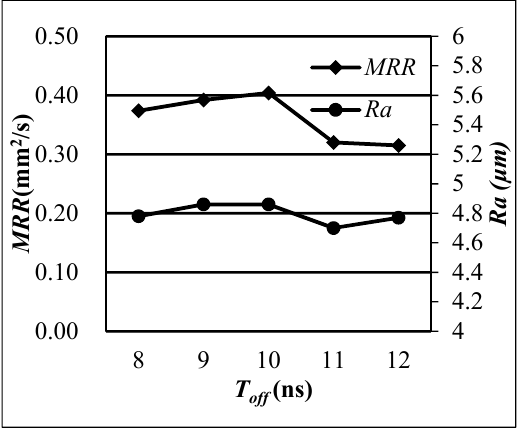
Figure 5. The effect of T off on MRR and SR.